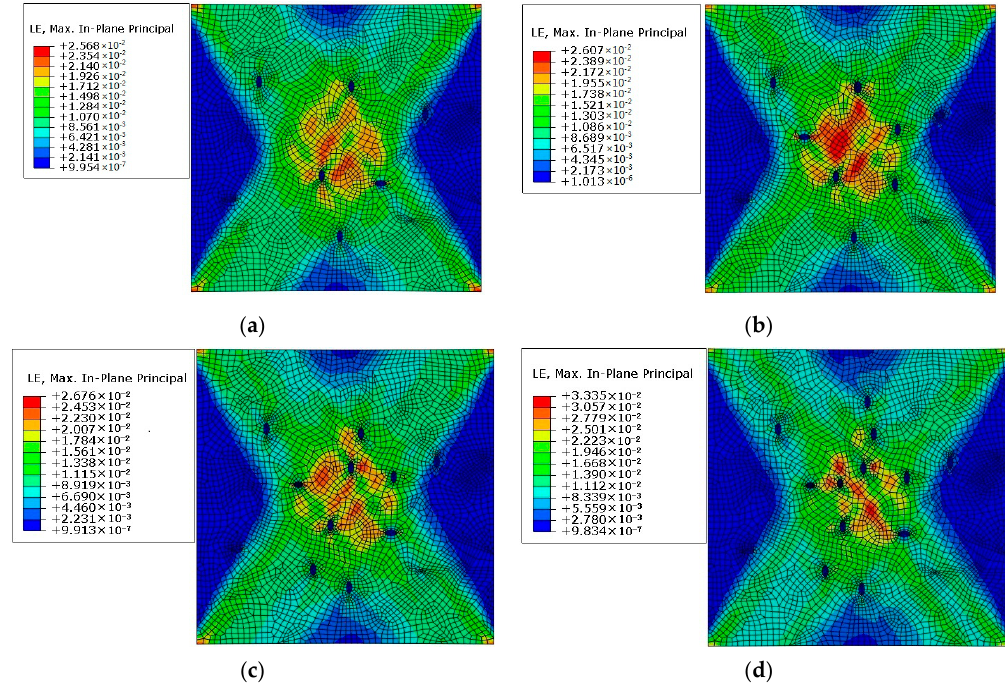
Figure 20. Strain distribution diagram of a polycrystalline model with different impurity percentages of ( a ) 0.44%, ( b ) 0.57%, ( c ) 0.70%, and ( d ) 0.82%.